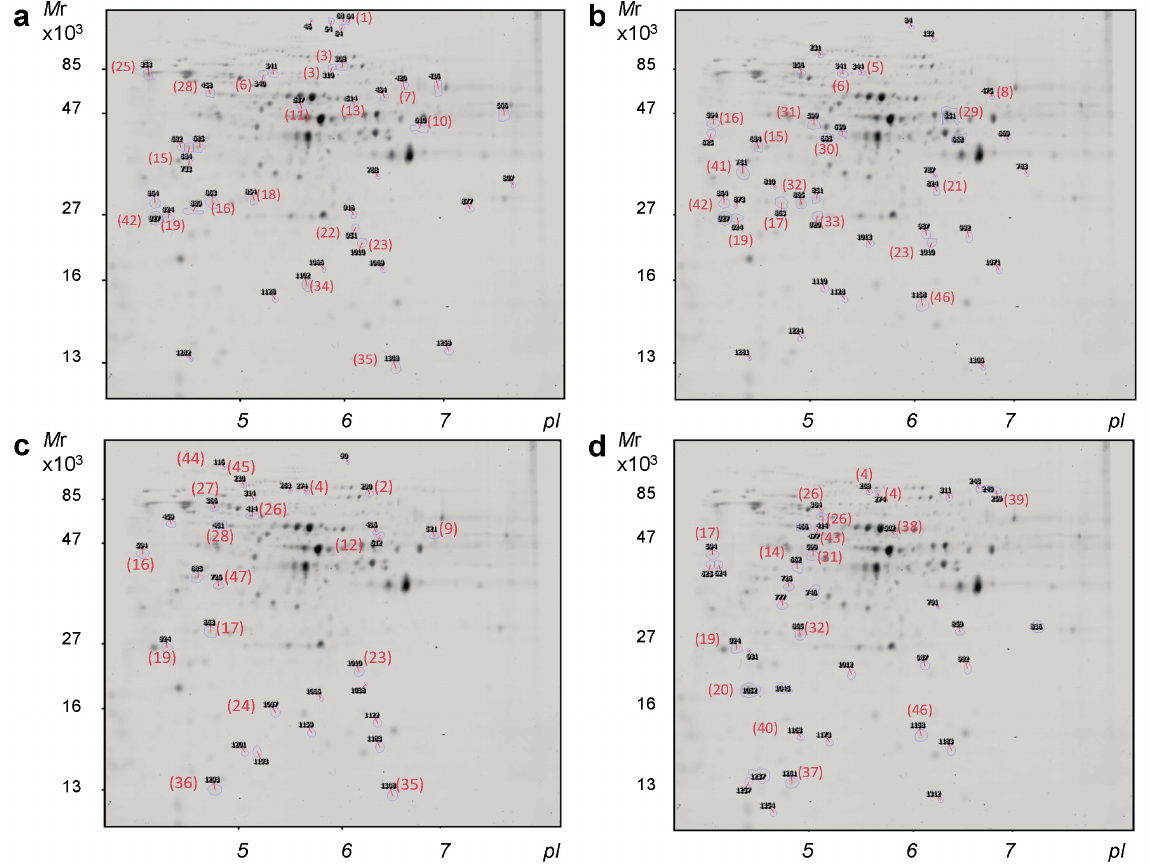
Figure 1. Representative phosphoproteome map showing the proteins with significant changes ( a ) in the S. cerevisiae W303-1A haploid strain after treatment with cisplatin; ( b ) in the W303-1A-derived Δ sky1 mutant after treatment with cisplatin; ( c ) in the W303-1A strain versus its Δ sky1 mutant; ( d ) in the W303-1A strain versus its Δ sky1 mutant, after treatment with cisplatin. Proteins were resolved in the 3–11 (nonlinear) pH range in the first dimension and on 12% acrylamide gels in the second dimension. Proteins identified by MALDI (Matrix-assisted laser desorption/ionization)-TOF (Time of Flight)/TOF mass spectrometry are listed in Table 1, where ID numbers correspond to the numbered spots in this figure (red numbers in